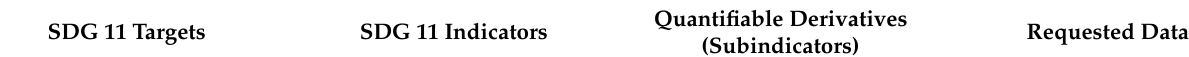
Table 5. List of SDG 11 targets and indicators and requested data for quantifying